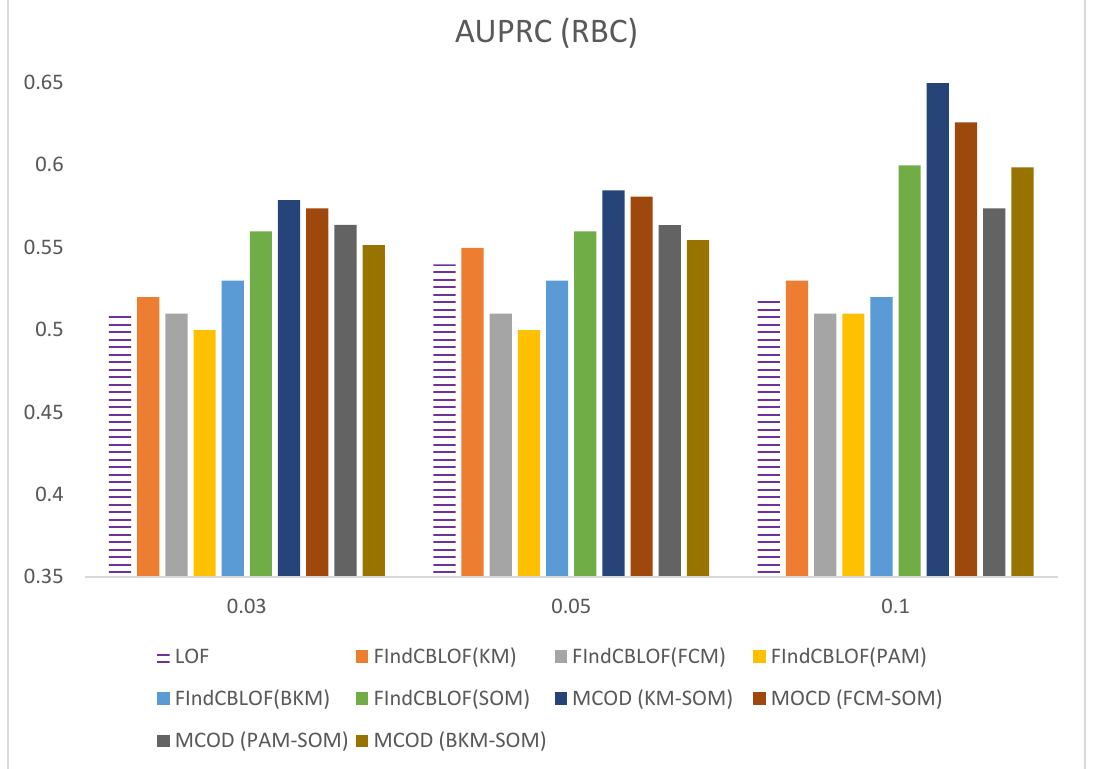
Figure 2. AUPRC (RBC Dataset).